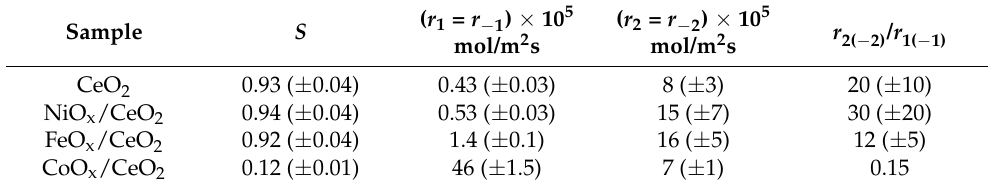
Table 4. Selectivity to two-atom exchange ( S ) and rates of different stages of oxygen isotope exchange.